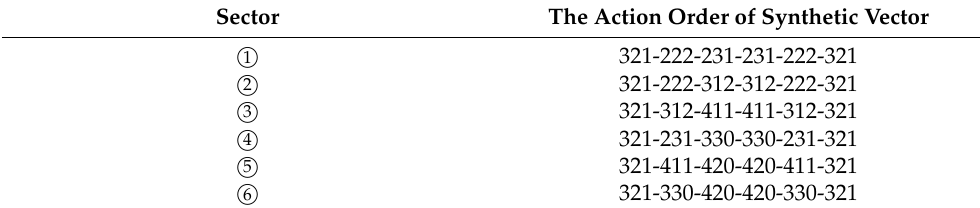
Table 4. The action time of the 0CMV-SVPWM synthetic